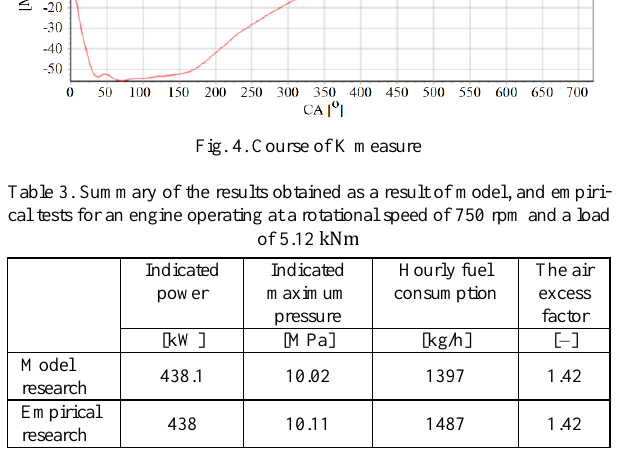
Table 4. Relative values of measures of model adequacy for an efficient engine Indicated power